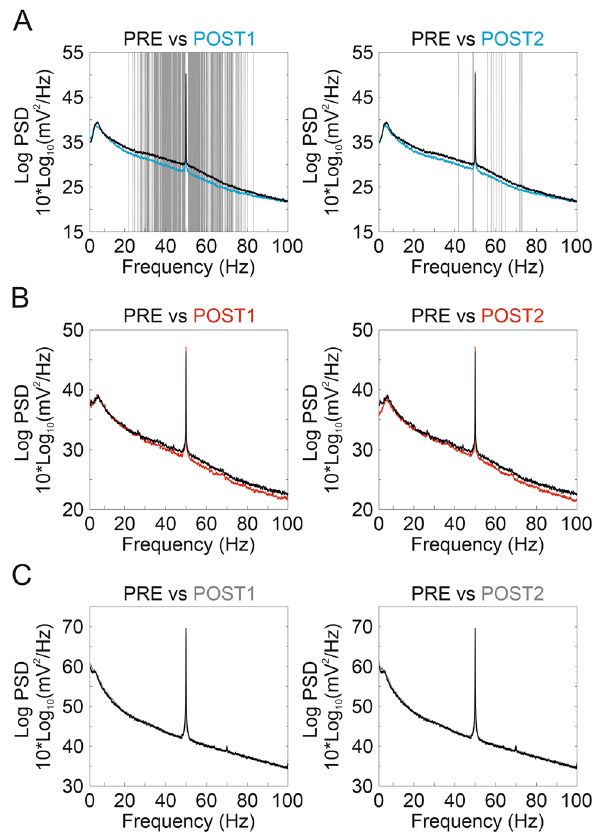
Figure 5. FFT analysis. ( A–C ) Comparison between the FFT obtained 20 min before the stimulation and the first 20 min after tDCS cessation (POST1, first column) or the next 20 min (POST2, second column) for cathodal ( A ), anodal ( B ) or sham ( C ) tDCS. Grey shadow represents statistical differences for a specific frequency ( p < 0.05,